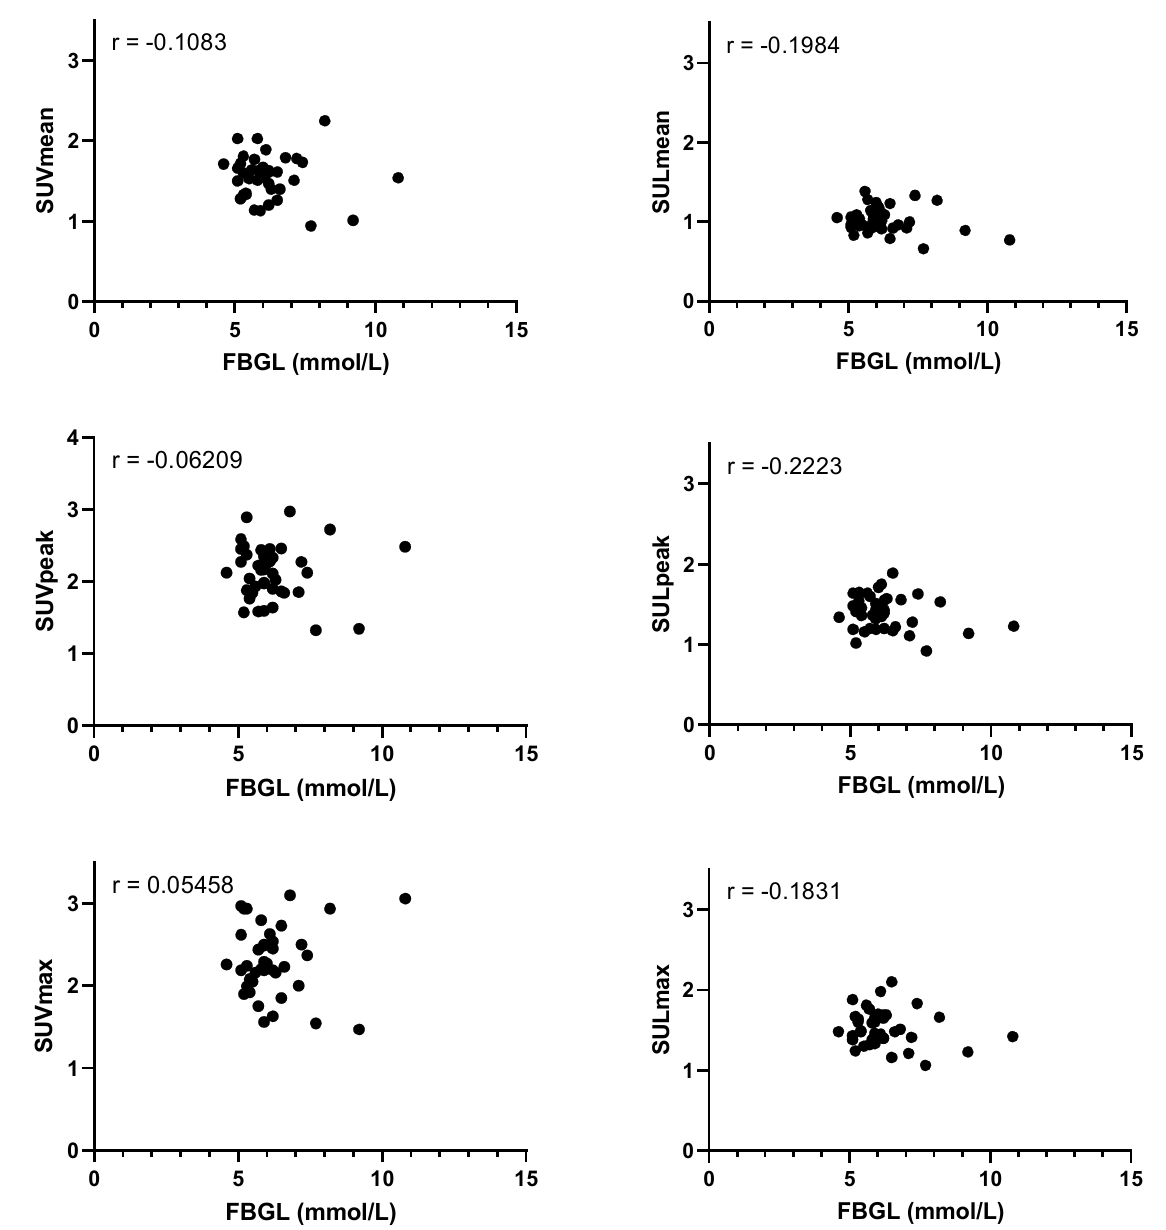
Figure 5. Plots of fasting blood glucose level (FBGL) in mmol/L and blood pool activity as measured by the mean standardized uptake value (SUV mean ), peak standardized uptake value (SUV peak ), maximum standardized uptake value (SUV max ), mean standardized uptake value corrected for lean body mass (SUL mean ), peak standardized uptake value corrected for lean body mass (SUL peak ), and maximum standardized uptake value corrected for lean body mass (SUL max ). Pearson’s r values are shown in the upper left corners. None of the correlations were statistically significant ( p = 1.000, p = 1.000, p = 0.735, p = 1.000, p = 0.974, p = 1.000 for SUV mean , SUV peak , SUV max , SUL mean , SUL peak , SUL max , respectively).